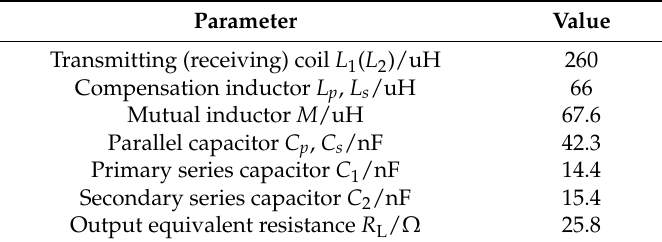
Figure 6. Voltage and current of MOSFET ( a ) t DT = 500 ns; ( b ) t DT = 1.2 us.